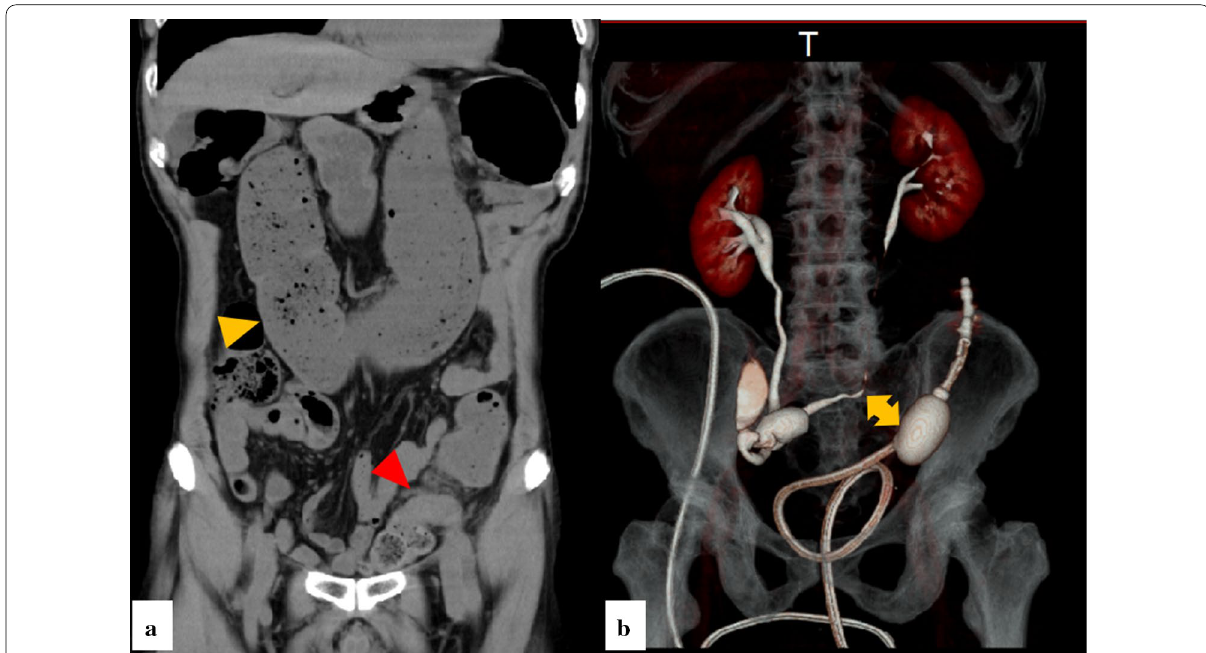
Fig. 1 Preoperative computed tomography. a Computed tomography (CT) confirms colon dilation with fecal impaction from the ascending colon to the sigmoid colon (yellow arrowhead) and wall thickening in the sigmoid colon (red arrowhead). b CT colonography demonstrates that the left ureter was near the sigmoid tumor (yellow